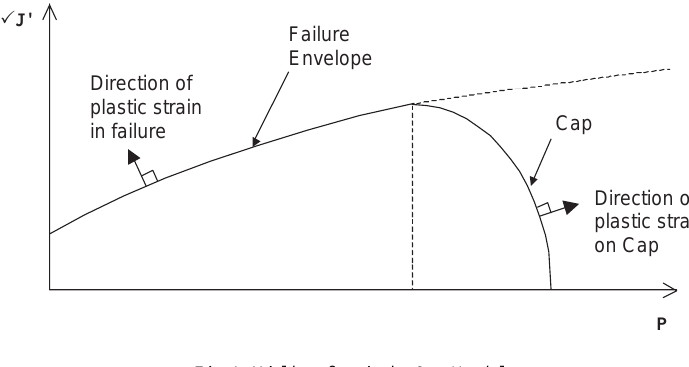
Fig. 1. Yield surface in the Cap